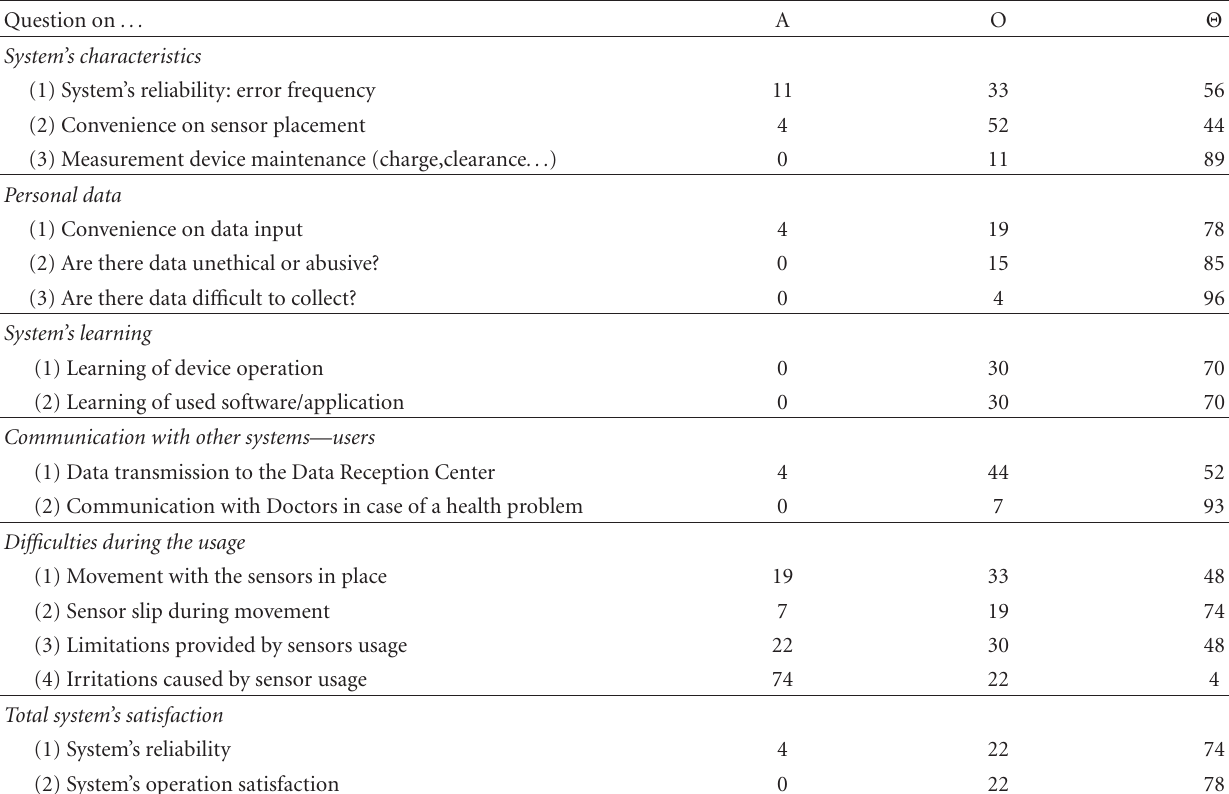
Table 6: Patient’s questionnaire